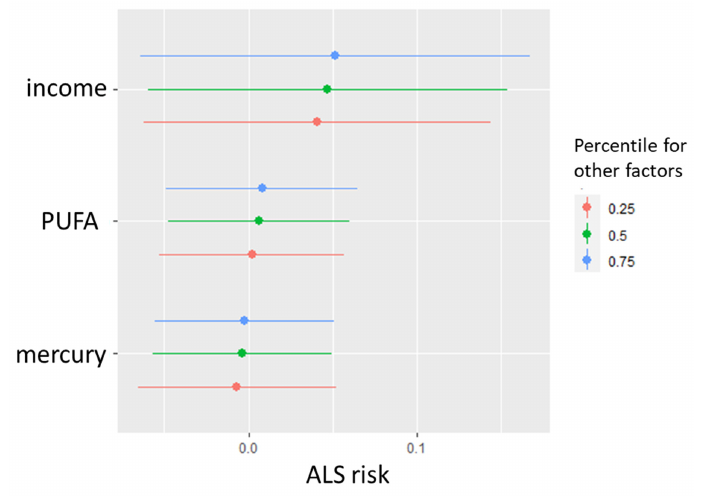
Figure 4. Relationship between income and both estimated mercury and omega-3 PUFA intakes via fish and